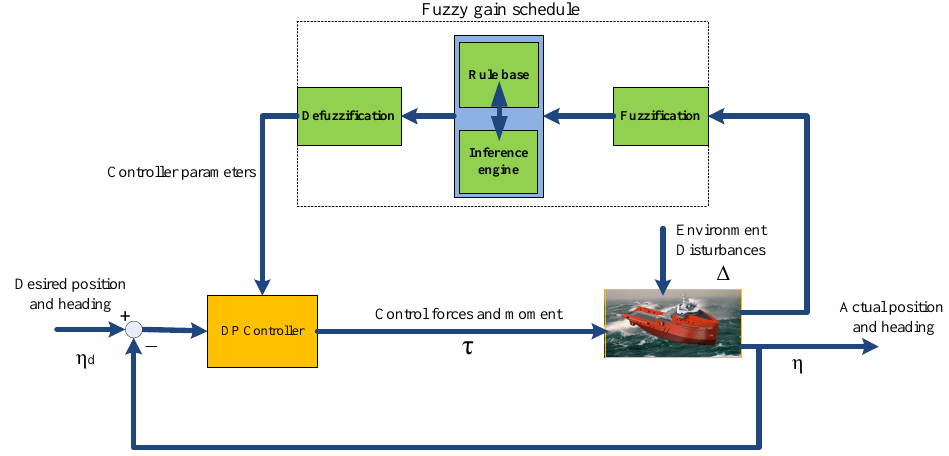
Figure 9. Blocks of a DP fuzzy adaptive controller.